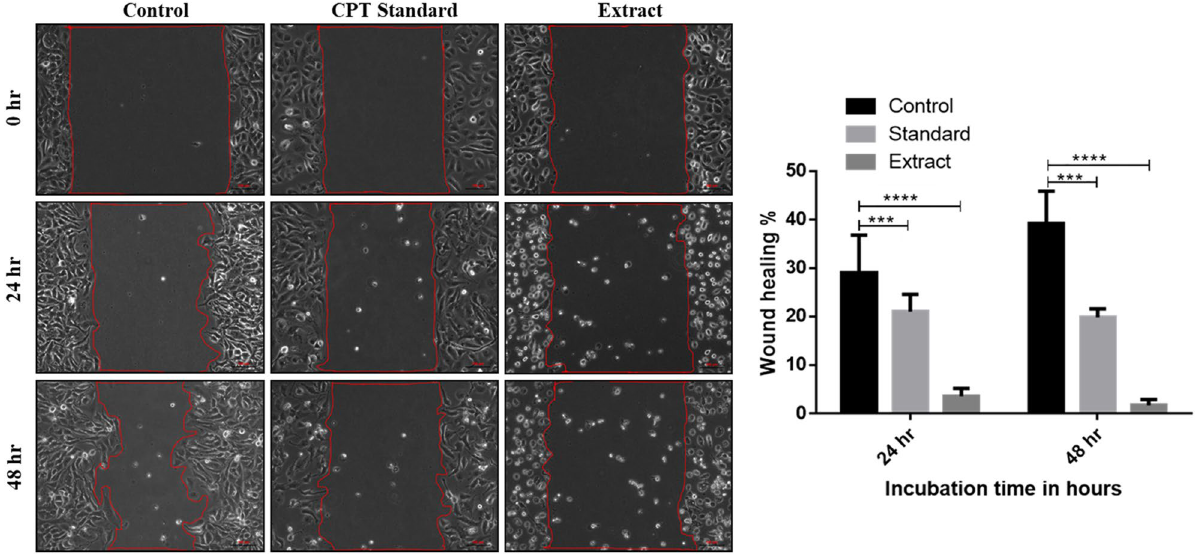
Figure 5. Minimal wound healing observed with A. burnsii extract-treated SKOV3 cell line. Control cells showed 29% and 39% healing after 24 and 48 h respectively, while the standard camptothecin treated